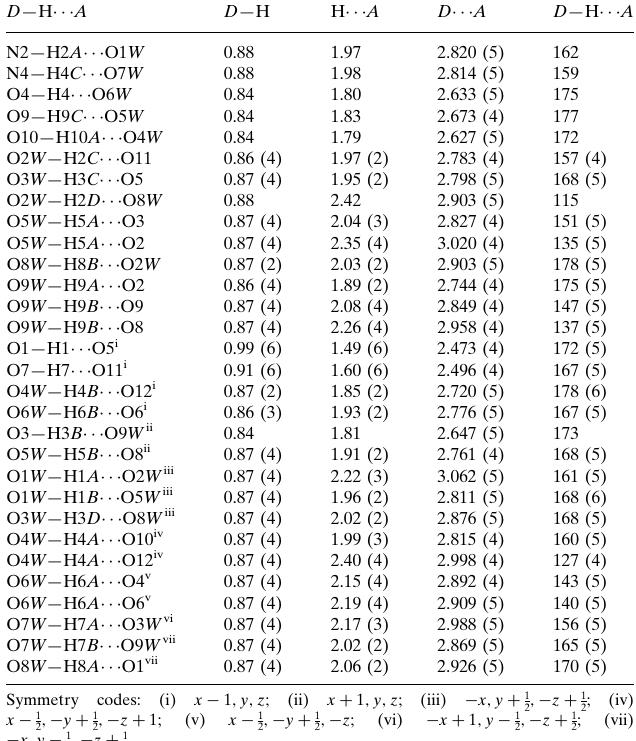
Hydrogen-bond geometry (A˚ , (cid:5) ). D —H (cid:2)(cid:2)(cid:2)